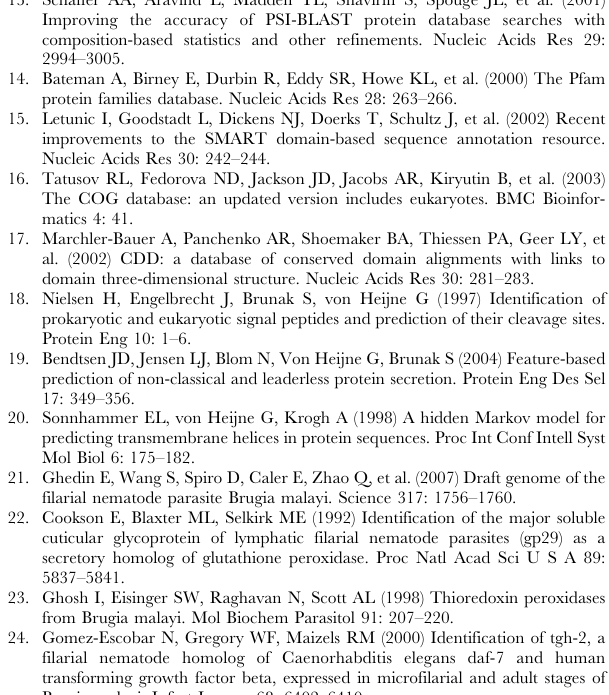
the number denotes number of proteins that the peptide has matched hits by BLASTP). Non-unique peptides are highlighted in yellow. Table S5 L3-ES Peptide List. The table describes the peptides identified and the corresponding protein in the ES of Brugia malayi L3 larvae. NTPS - Number of times peptide seen; NSH - Non- specific hits (Peptides matching with more than one protein; the number denotes number of proteins that the peptide has matched hits by BLASTP). Non-unique peptides are highlighted in yellow. Table S6 L3-MES Peptide List. The table describes the peptides identified and the corresponding protein in the ES of Brugia malayi L3 larvae molting into L4 stage. NTPS - Number of times peptide seen; NSH - Non-specific hits (Peptides matching with more than one protein; the number denotes number of proteins that the peptide has matched hits by BLASTP). Non-unique peptides are highlighted in yellow. Table S7 Wolbachia ES. List of proteins in the secretome being identified as Wolbachia in